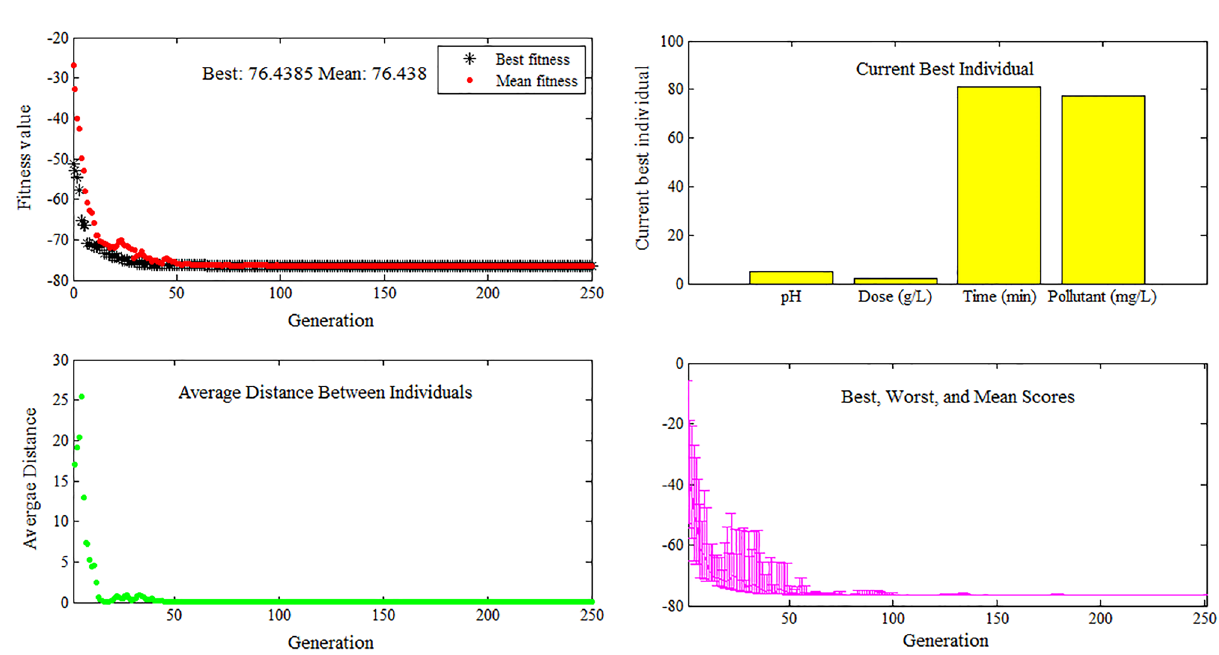
Figure 9. AR18 optimization using genetic